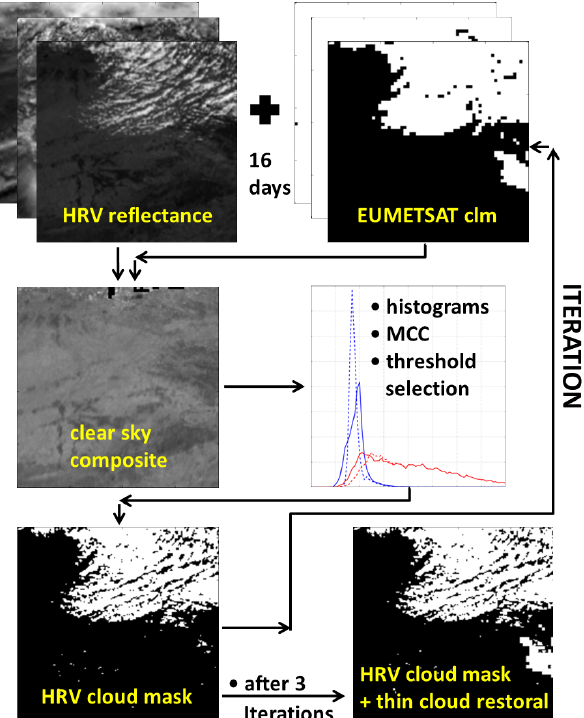
Fig. 6. Flow chart of our HRV cloud mask algorithm, based on the HRV reflectance and the EUMETSAT cloud mask as inputs. Fig.6. FlowchartofourHRVcloudmaskalgorithm,basedontheHRVreflectanceandtheEUMETSATcloud The clear-sky composite is initially calculated based on the HRV maskasinputs. TheclearskycompositeisinitallycalculatedbasedontheHRVreflectanceandtheEUMETSAT reflectance and the EUMETSAT cloud mask for 16-day periods. cloud mask for 16 day periods. The panel showing the histograms represents the threshold selection step based The panel showing the histograms represents the threshold selec- onmaximizingtheMCC.Asfinalstep,thethincloudrestoraltoconsiderthincloudsiscarriedout. Aniterative tion step based on maximizing the MCC. As a final step, the thin approachincludingtheHRVcloudmaskischosenforthecalculationoftheclearskycompositeforconsistency. cloud restoral to consider thin clouds is carried out. An iterative ap- proach including the HRV cloud mask is chosen for the calculation of the clear-sky composite for 20